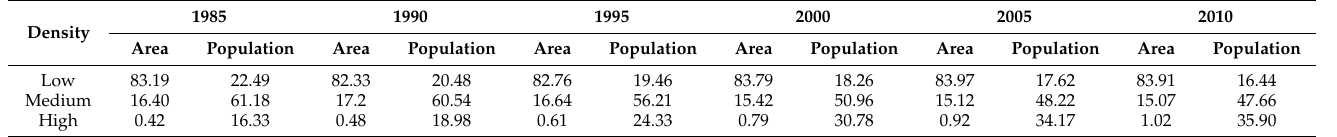
Figure 14. Gridded population data (1 km × 1 km) of China from 1985 to 2010. Table 3. Percentage values of area and population for different density